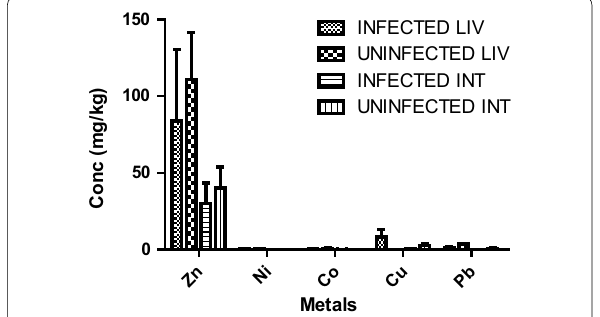
Fig. 2 Comparative concentrations of metals in the biological samples. Liv. Liver. Int. = =